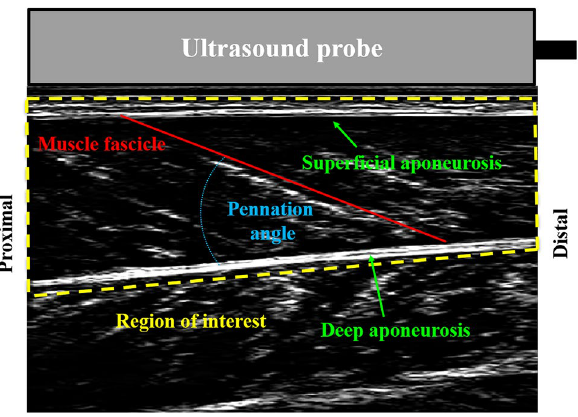
Figure 4. Exemplary image of the gastrocnemius medialis muscle fascicle during